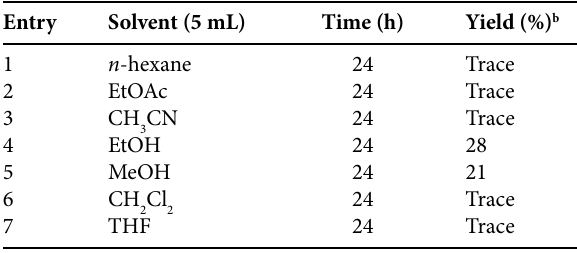
Table 2. The one-pot condensation reaction between isatin ( 1a ), 5,5-dimethylcyclohexane-1,3-dione ( 2a ), and cyclohexyl isocya- nide ( 3a ) with the presence of SDS in various solvents at reflux conditions.